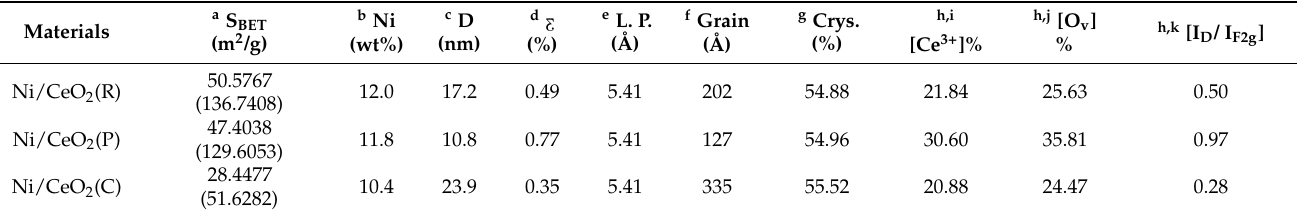
Table 1. Physicochemical and structural properties of different Ni/CeO 2 catalytic